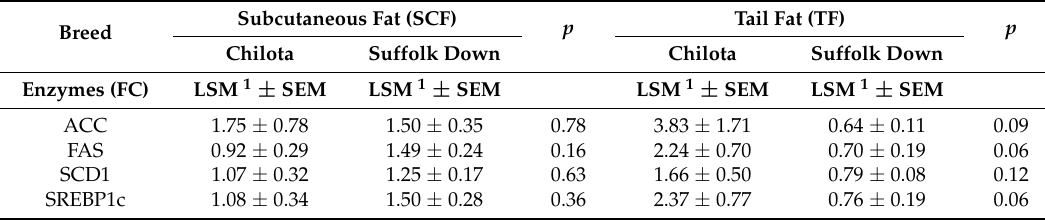
Table 2. Relative mRNA expression level differences (expressed as fold change, FC ) in subcutaneous and tail fat samples from Chilota ( n = 8) and Suffolk Down ( n = 6) lambs grazing Calafatal pasture. Subcutaneous Fat (SCF) p Tail Fat (TF) p Breed Chilota Suffolk Down Chilota Suffolk Down